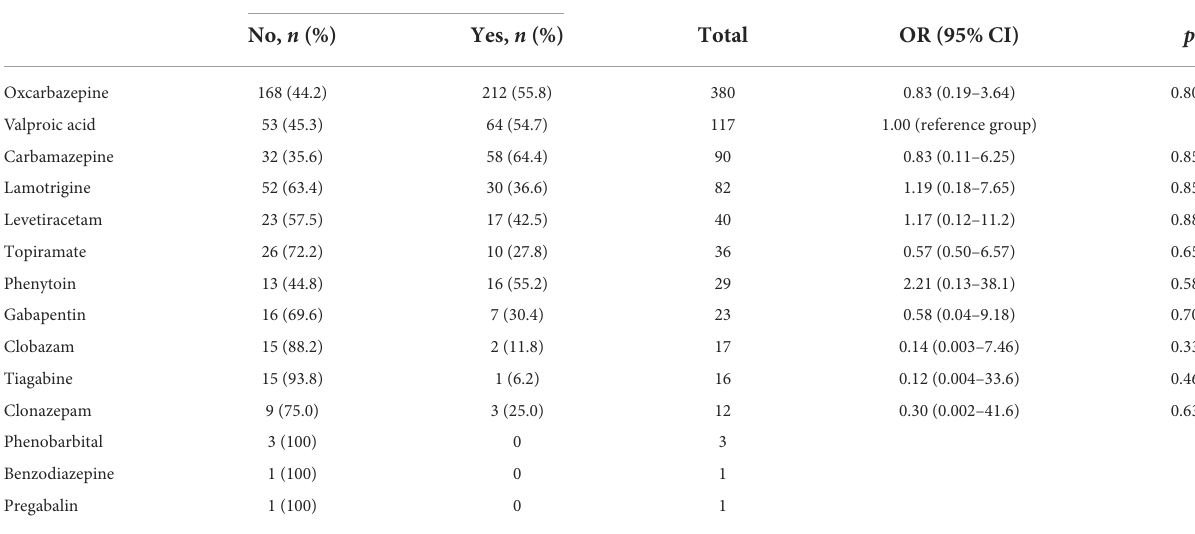
TABLE 5 Efficacy of antiseizure medications used in mono- or polytherapy. Seizure freedom